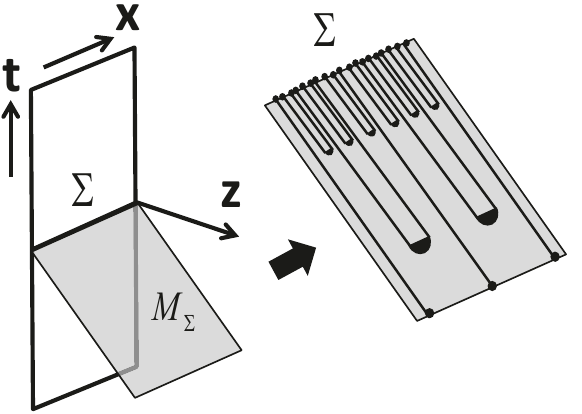
Figure 10 . A sketch of a quantum circuit dual to a null surface. Strictly speaking we need to maintain the translational invariance with suitable